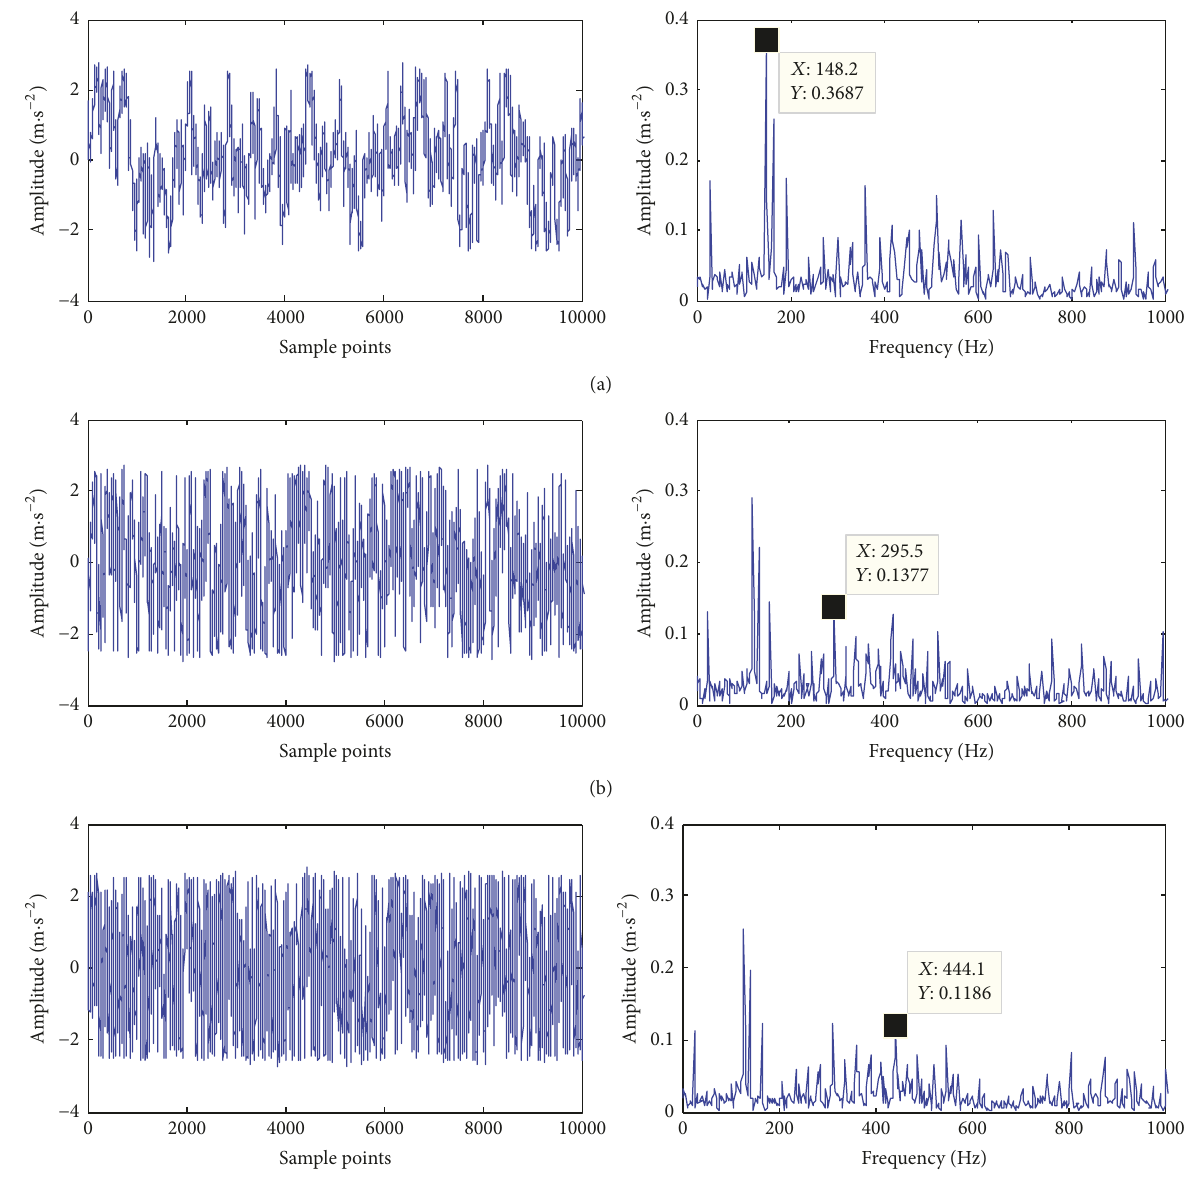
Figure 14: The time domain and spectrum of output signal through the rescaling multistable SR with different double sample frequency: (a) 1.4Hz, (b) 1.6Hz, and (c) 2Hz.